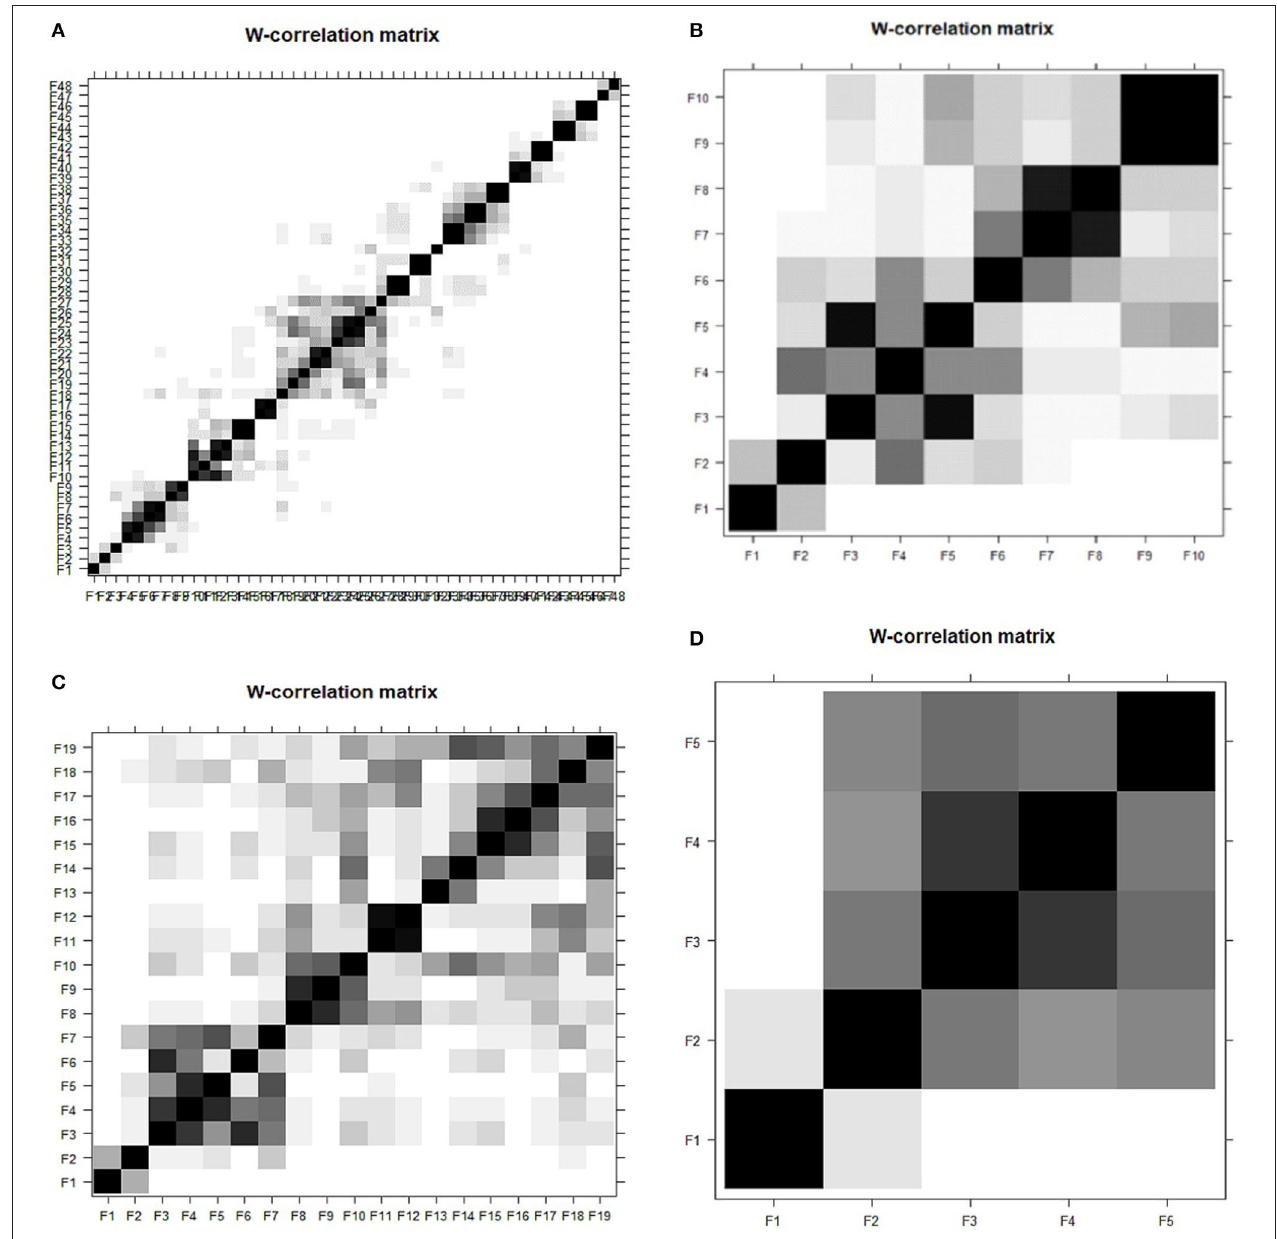
FIGURE 5 | (A–D) w-correlation plot using SSA with varied windows length (A) L